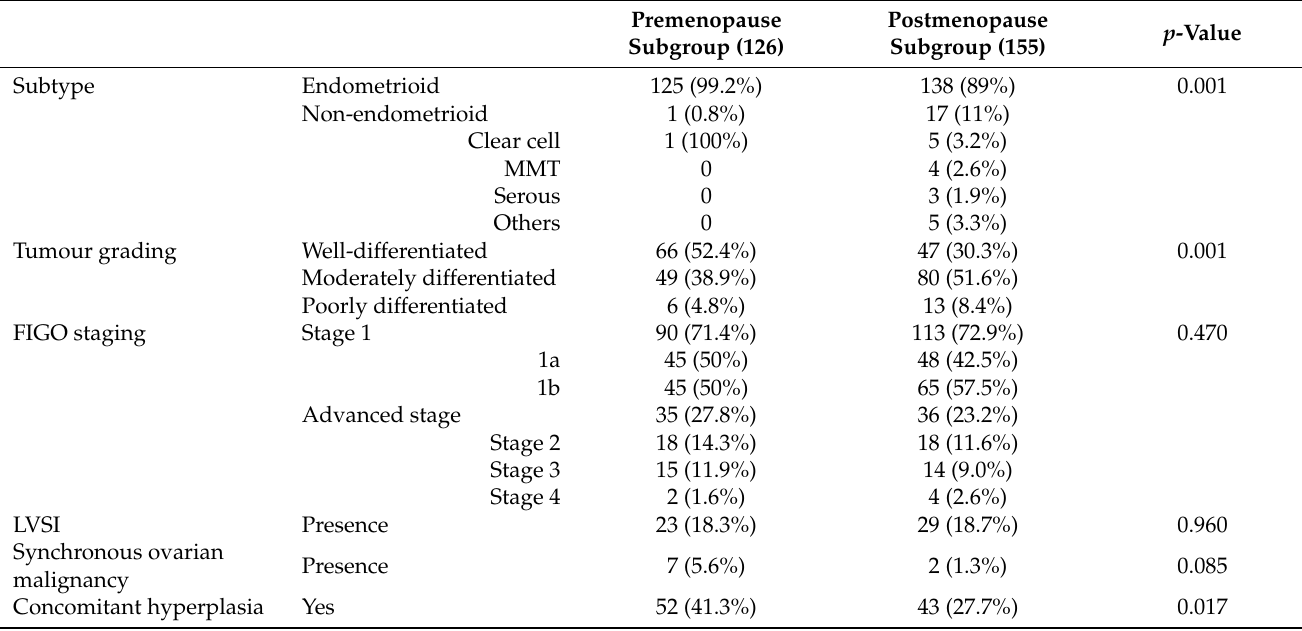
Table 2. Clinicopathological characteristics of endometrial cancer